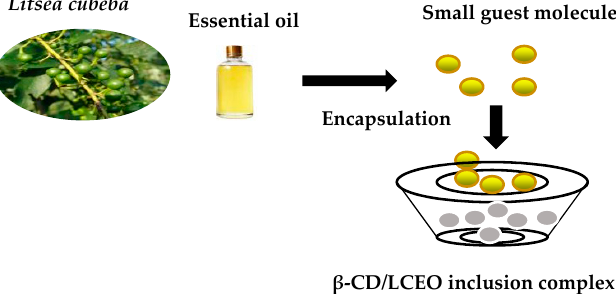
Figure 1. Theformingschemeof Litseacubeba essentialoil(LCEO) / β -cyclodextrin( β Figure 1. The forming scheme of Litsea cubeba essential oil (LCEO)/ β -cyclodextrin ( β -CD) inclusion complex.